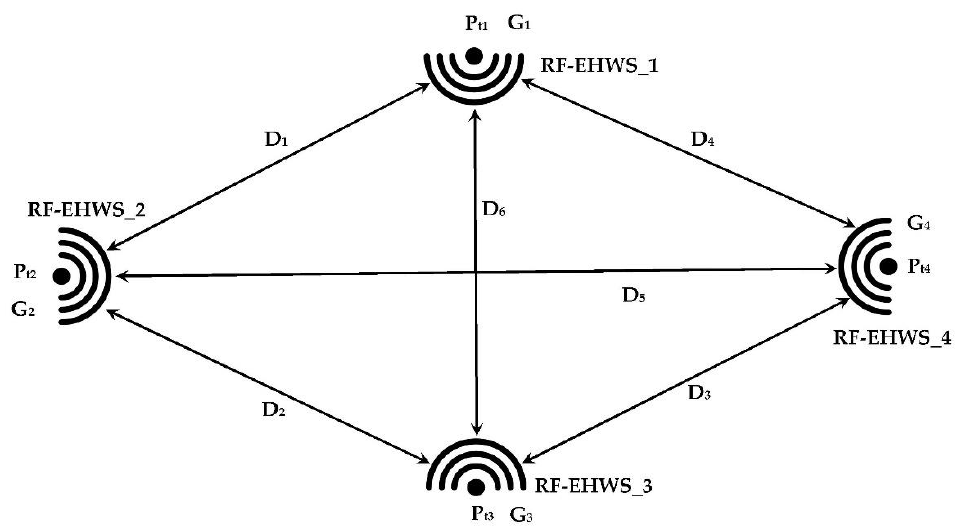
Figure 37. WSN system architecture for self-powering process